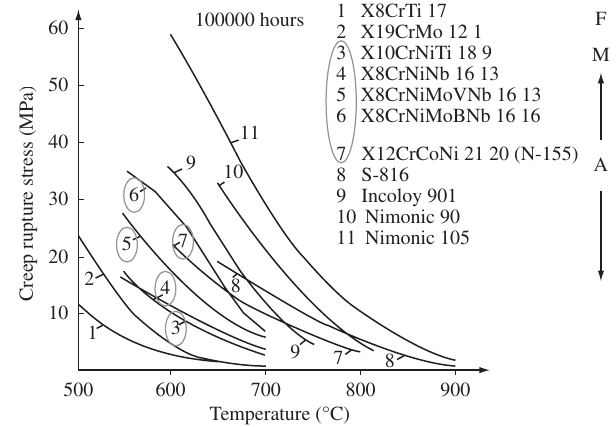
Figure 6. Micrographs 46 of the gauge portion of the tested sample (550 °C /150 MPa/85000 h), showing precipitation of sigma phase in AISI 316L(N), a) from delta ferrite islands; and b) at austenite grain boundary and triple points. Etching: